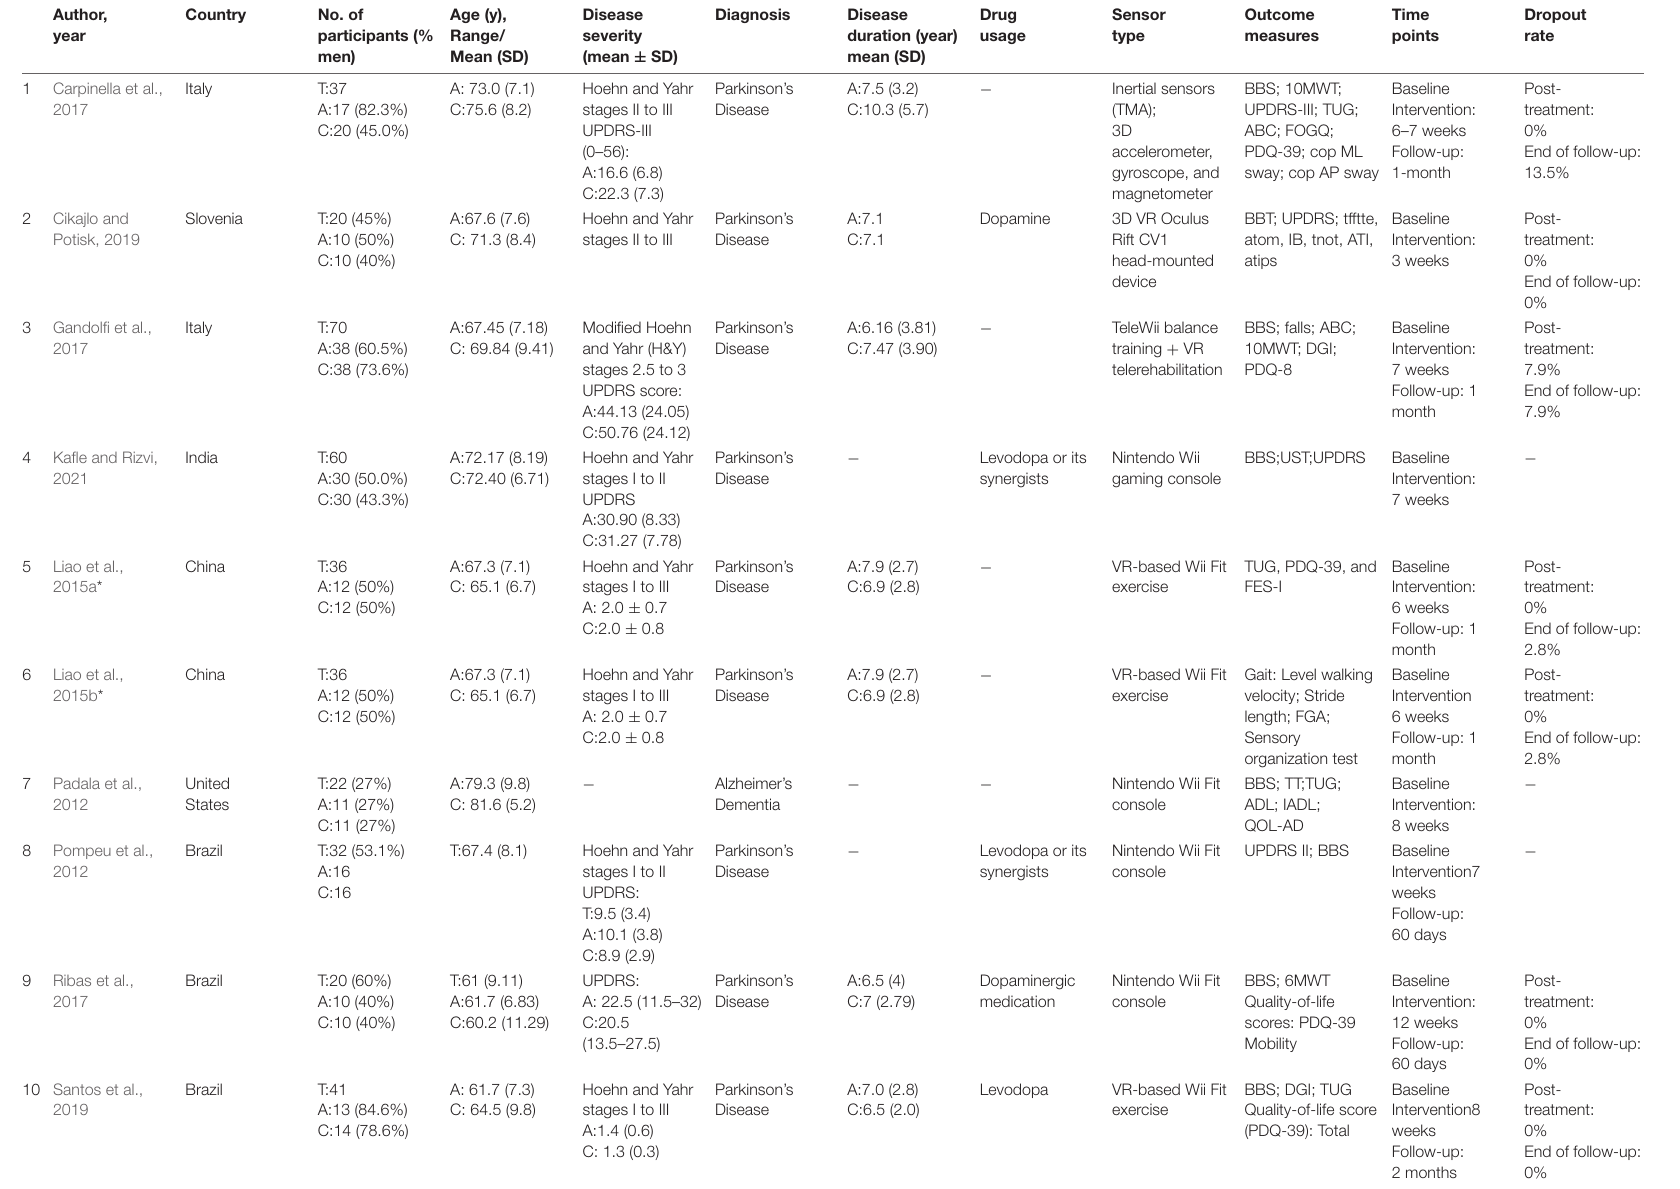
TABLE 2 | Characteristics of the included studies.